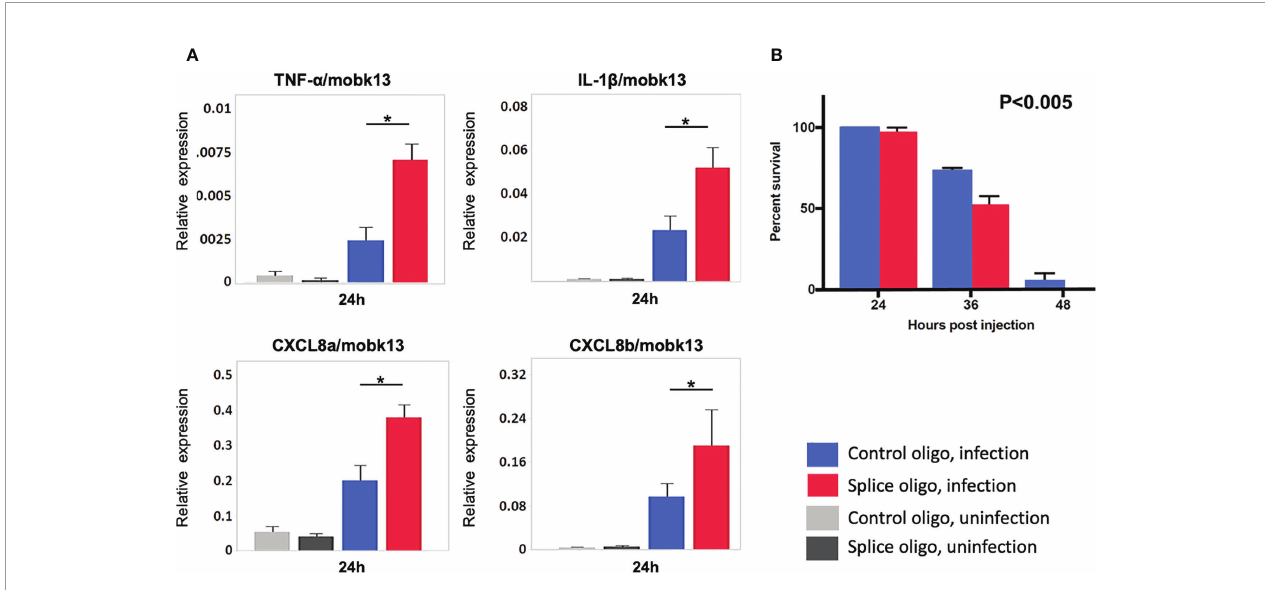
FIGURE 6 | HIVEP1 knockdown increases systemic in fl ammation and impairs survival in zebra fi sh embryos with sepsis. (A) RNA expression of in fl ammatory cytokines normalized to mobk13 measured by RT-qPCR. Zebra fi sh embryos (n = 10) were pooled into one biological replicate and fi ve independent experiments were performed. Data shows mean ± SEM (B) The survival rate was signi fi cantly lower in the HIVEP1 splice morpholino injected group than that in control (n = 20 per group). Data shows means ± SEM. Experiment performed in triplicate. Survival rates were compared using log-rank statistics. *P <